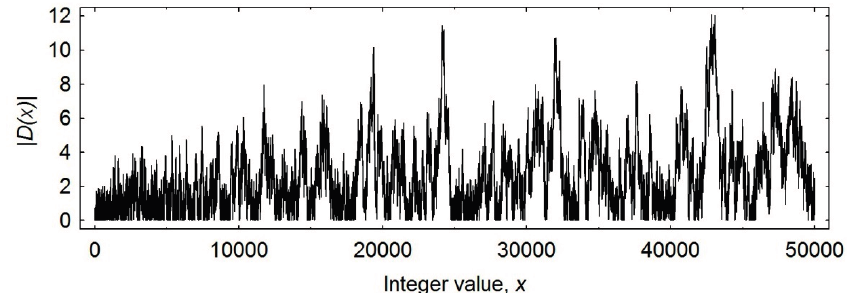
Figure 1. The absolute value | D ( x )| of the discrepancy between the prime counting function π ( x ) and Riemann’s formula R ( x ) for the first 50,000 integers.